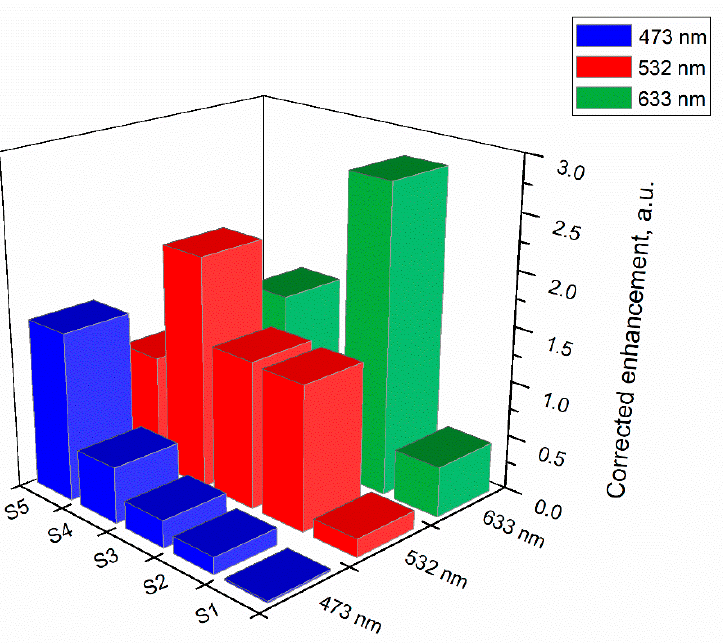
Figure 9. Variation of the enhancement for S1–S5 as a function of the excitation laser. Please note that the enhancement is given in arbitrary units.